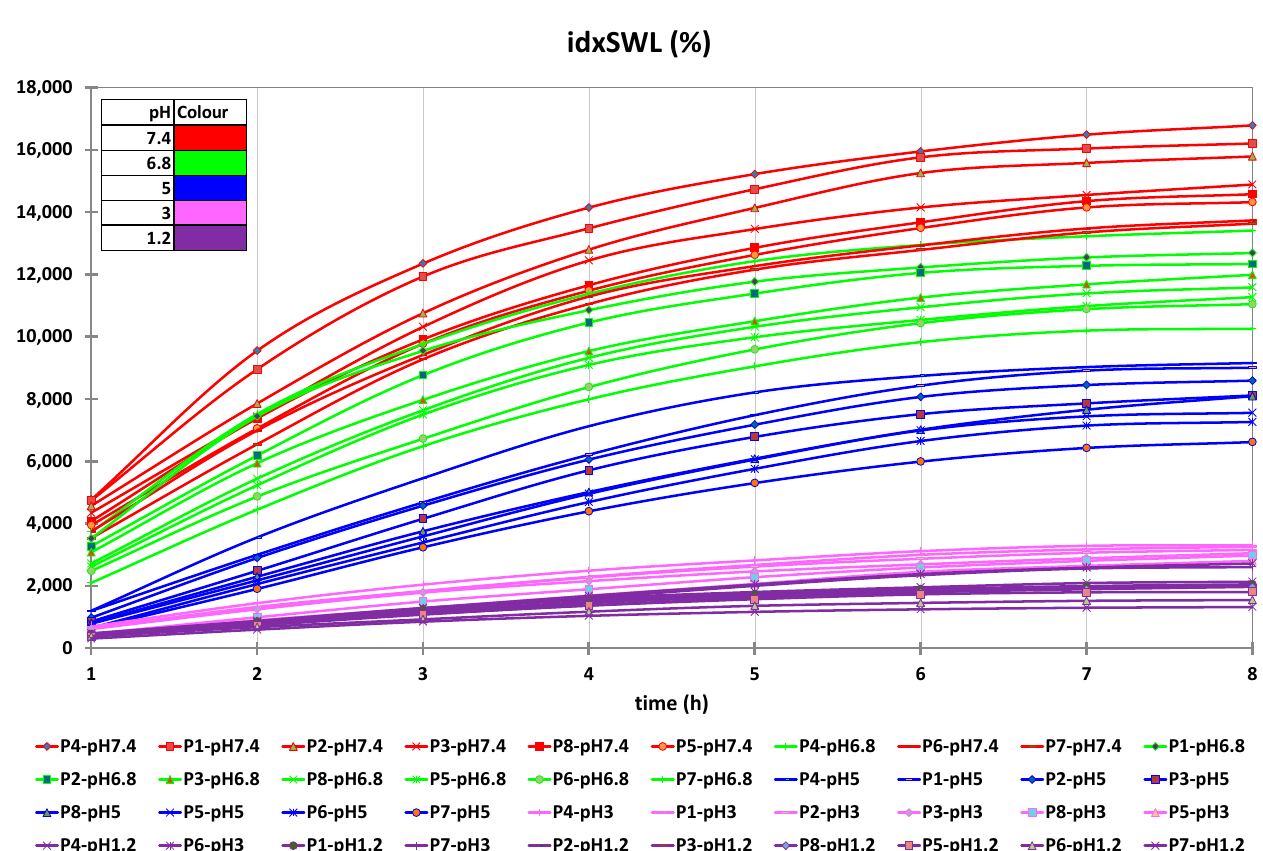
Figure 7. Interval plots of the swelling index (idxSWL (%)) of the microspheres for Sample * pH * Time interaction factor levels.